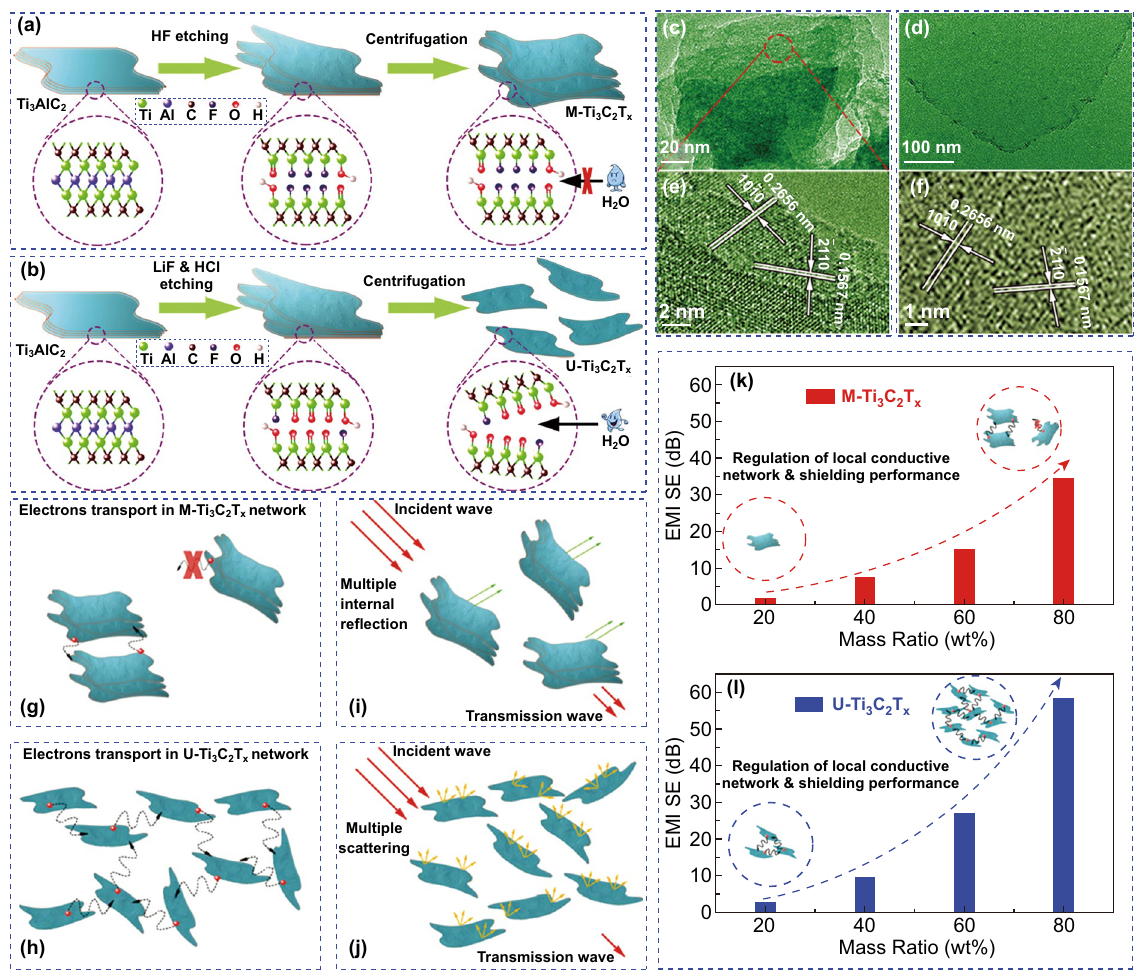
Fig. 4 Synthetic illustration of a multilayer Ti 3 C 2 T x and b Ti 3 C 2 T x nanosheet. The high‑magnification TEM images of c multilayer Ti 3 C 2 T x d Ti 3 C 2 T x nanosheet. HRTEM images of e multilayer Ti 3 C 2 T x and f Ti 3 C 2 T x nanosheet. Local conductive network of g multilayer Ti 3 C 2 T x and h